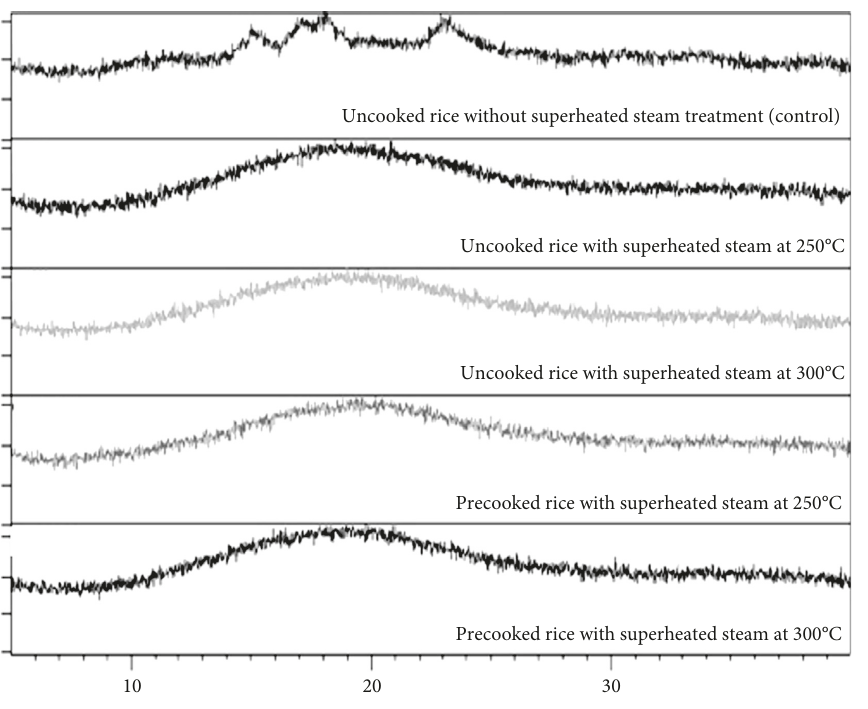
Figure 4: X-ray diffraction patterns of black glutinous rice with/without superheated steam treatment. Table 2: Texture profile of cooked black glutinous rice with/without superheated steam